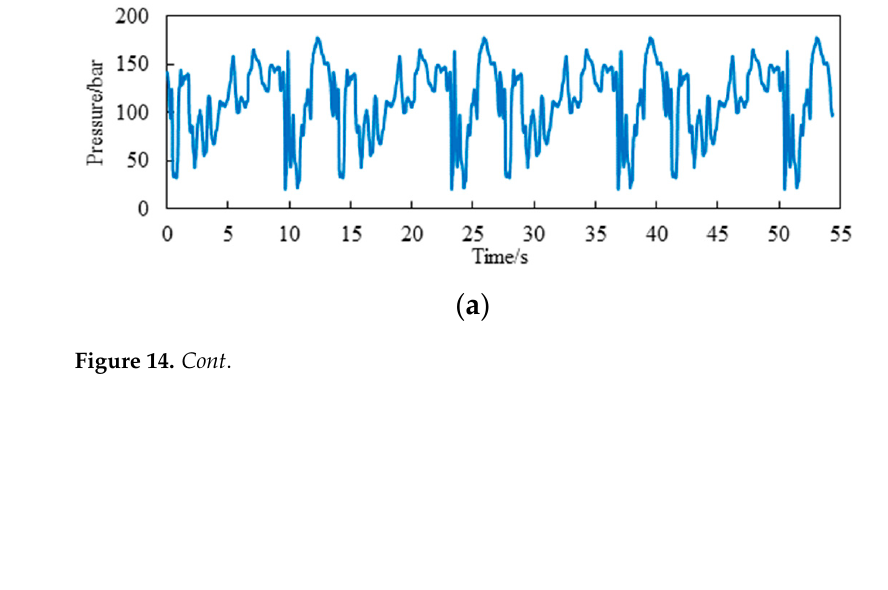
Figure 13. The typical working condition load reconstruction.